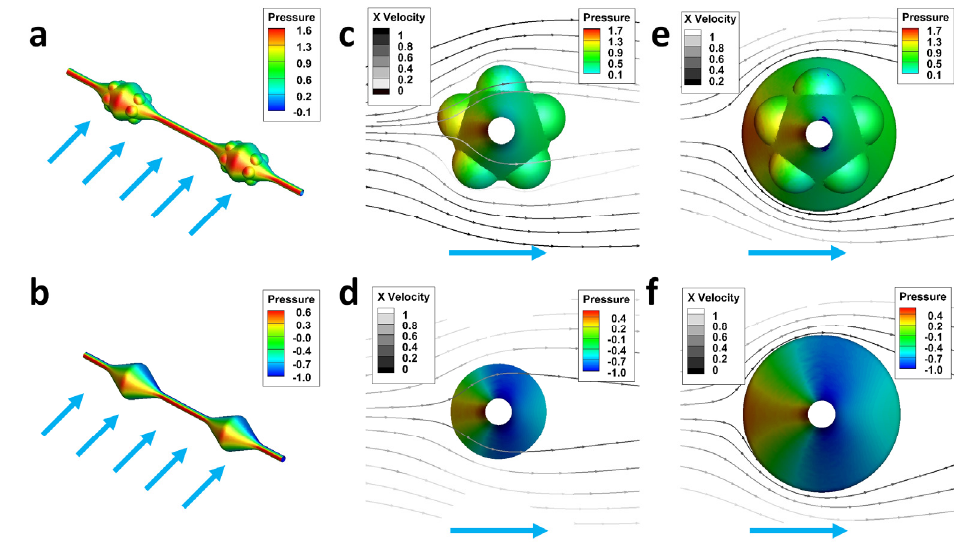
smooth: Figure 6f, P max = 0.6 Pa, P min = − 1.0 Pa). From the view of diffusion, the Brownian motion becomes intense with decrease of fragment size according to Stokes-Einstein equation [23], which proves that the tiny water drops are much more easily to be caught by the particles than the fiber[18–21].